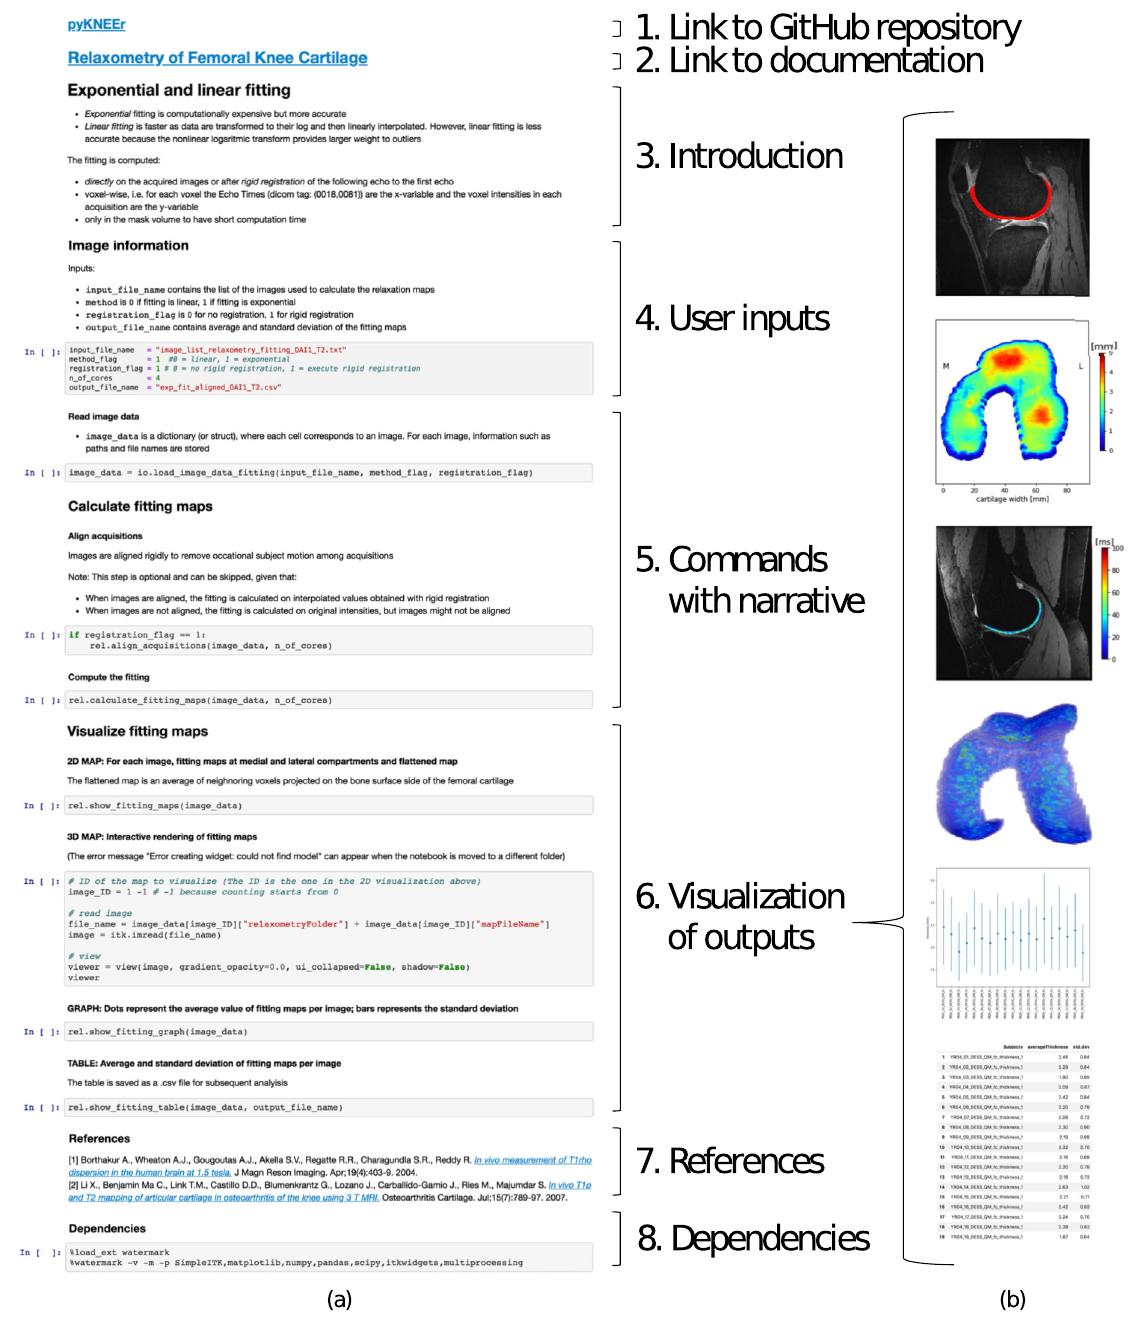
Fig 2. User-interface of modules in pyKNEEr . (a) Structure of Jupyter notebooks and (b) qualitative and quantitative visualization of outputs (from top: cartilage segmentation on image slice, flattened map of cartilage thickness, relaxation map on image slice, 3D relaxation map, and plot and table with average and standard deviation of thickness